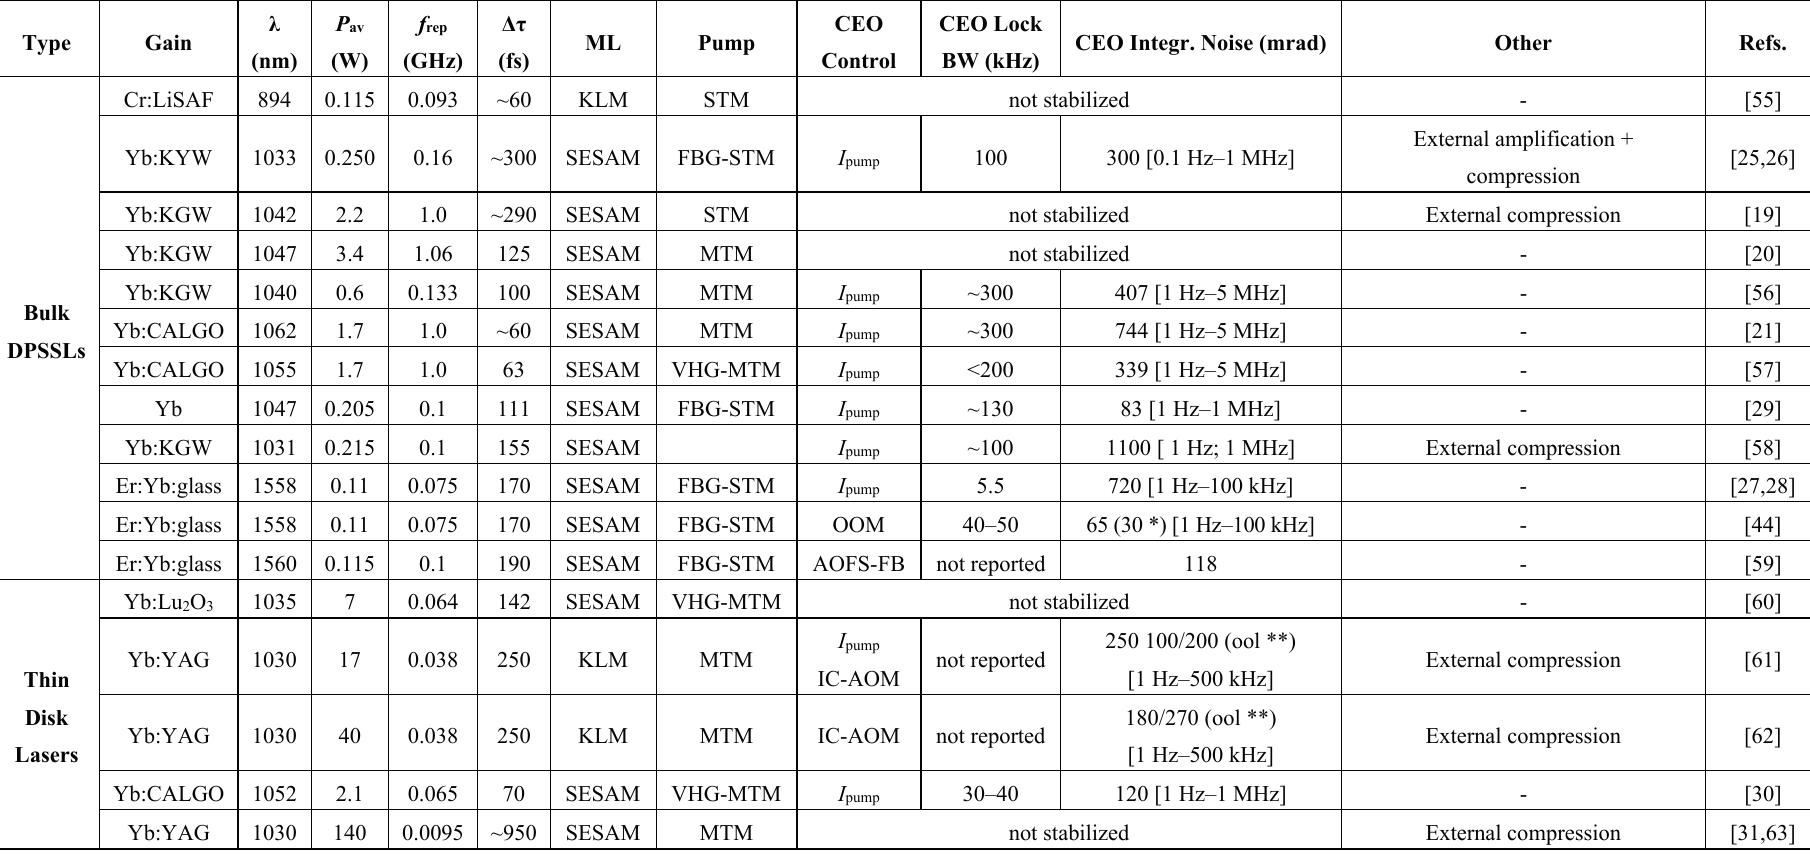
Table 1. List and main parameters of CEO-stabilized or self-referenceable DPSSLs reported in the literature (bulk DPSSLs and